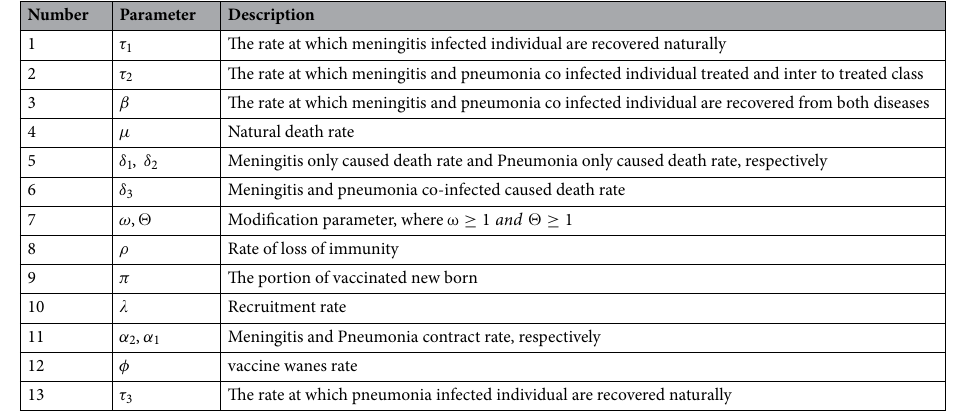
Table 1. Descriptions of parameters.